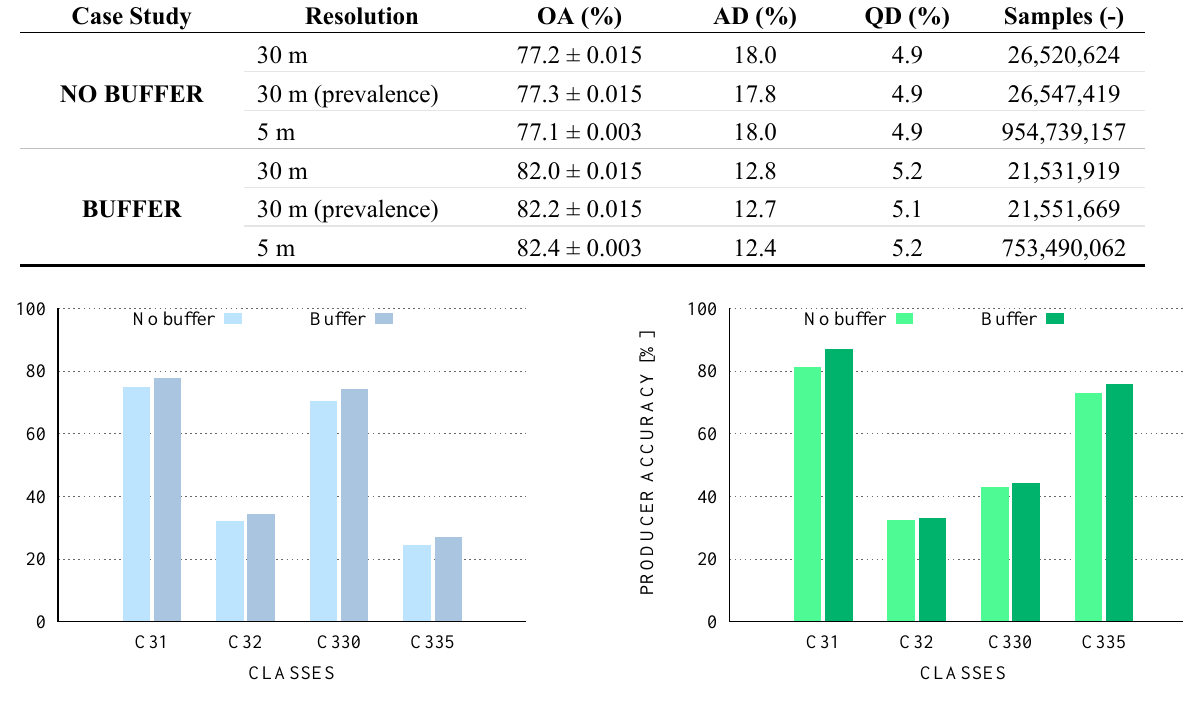
Figure 6. Comparison between GlobeLand30 2000 and DUSAF1.1 (II reclassification): per-class statistics referred to 30 m resolution input datasets. C31: forests; C32: herbaceous or/and grass vegetation associations; C330: open spaces with little or no vegetation; C335: glaciers and perpetual